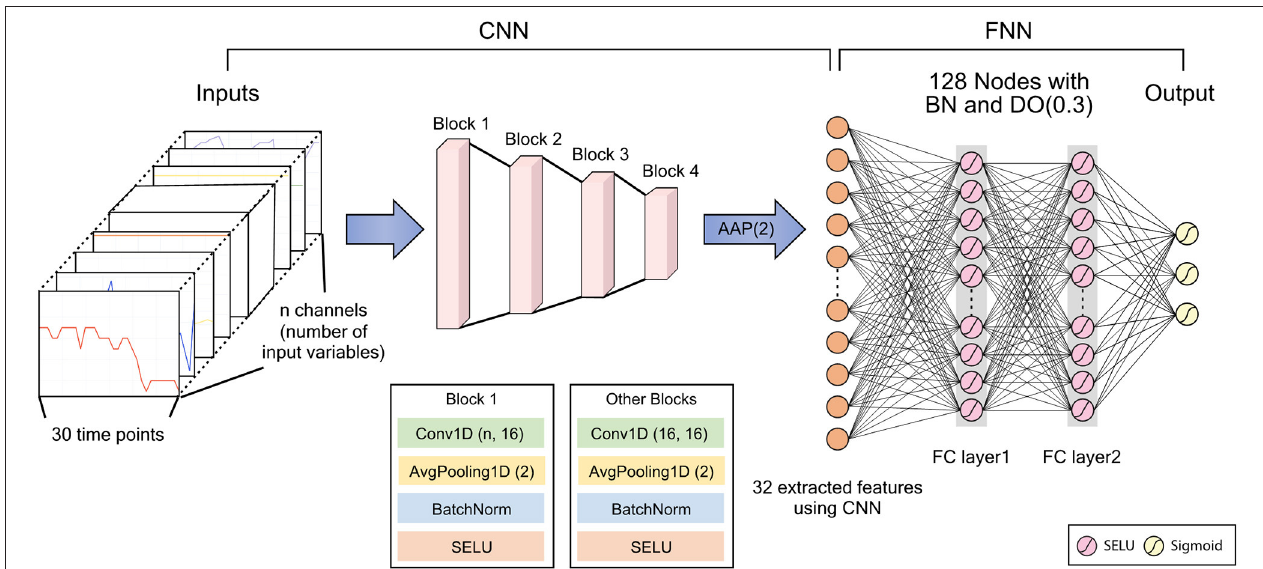
FIGURE 3 | Architecture of the deep learning model. CNN, convolutional neural network; FNN, feedforward neural network; BN, batch normalization; DO, dropout; AAP, adaptive average pooling; SELU, scaled exponential linear unit; FC, fully connected. DO (dropout rate), Conv1D (kernel size, number of filters), AvgPooling1D (kernel size).